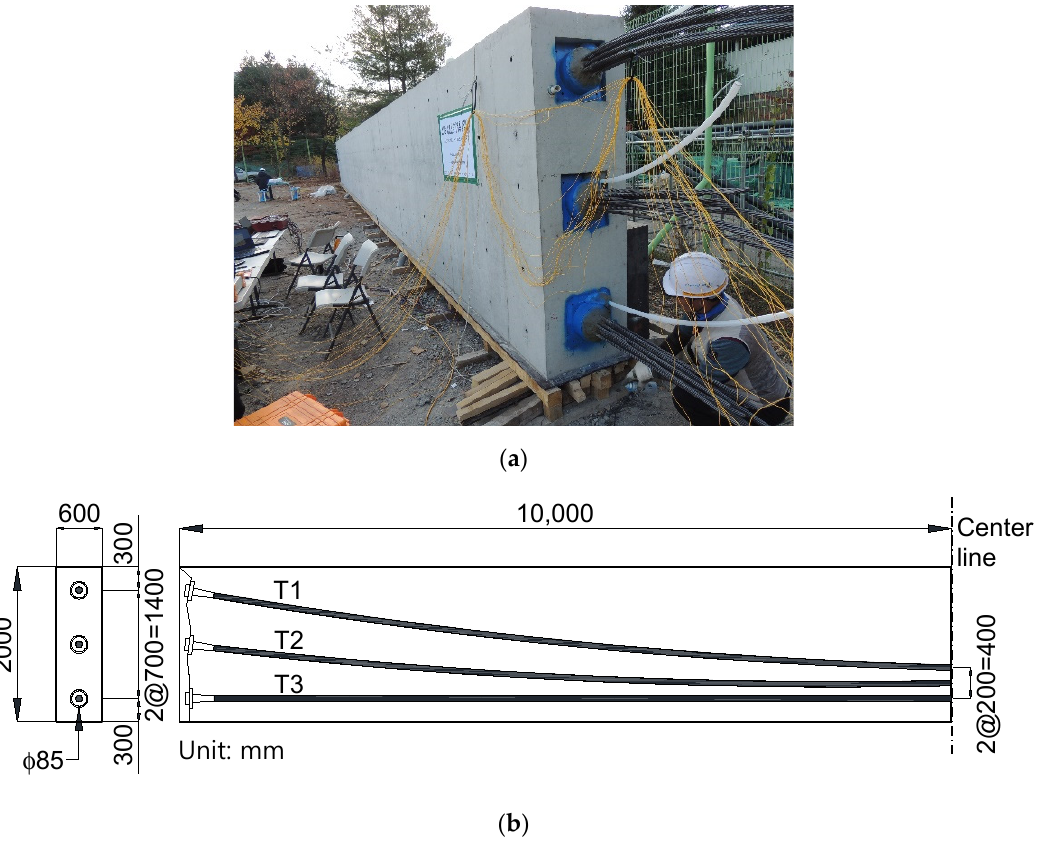
Figure 9. Post-tensioned full-scale specimen: ( a ) overall view; and ( b ) dimensions.